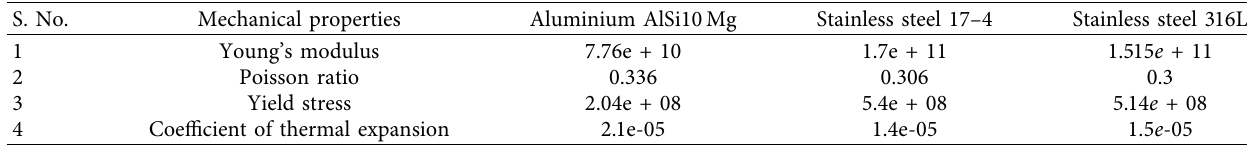
Table 3: Mechanical Properties of materials for 3-blade Propeller.